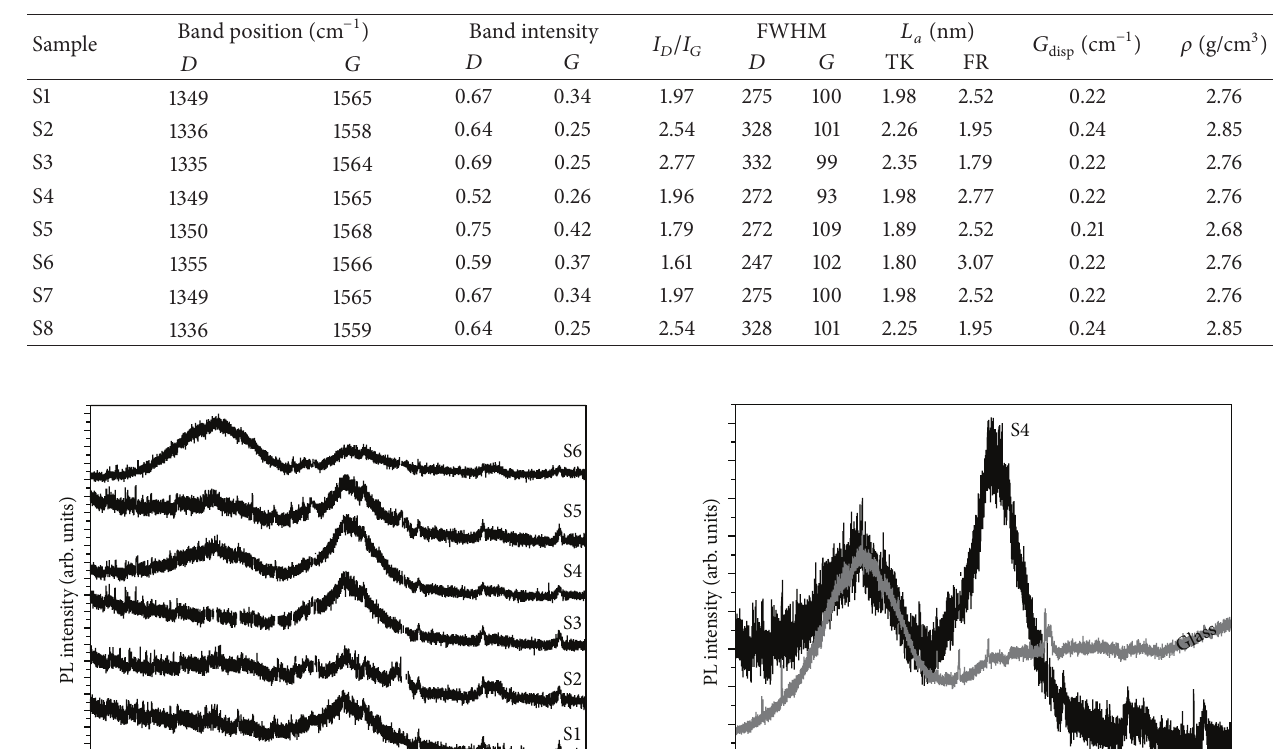
Table 2: Collected data obtained from the 𝐷 and 𝐺 bands of the Raman spectroscopy analyses.